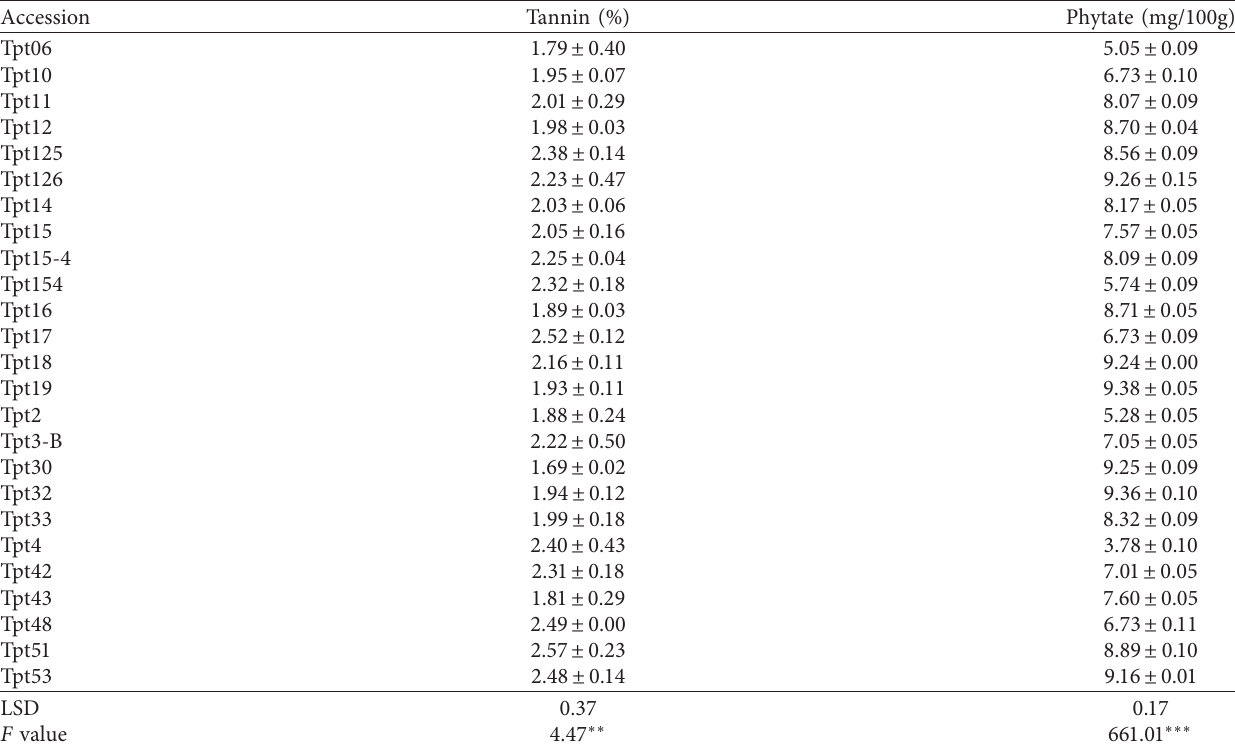
Table 3: Tannin and phytate concentration (mean ± standard deviation) of processed winged bean